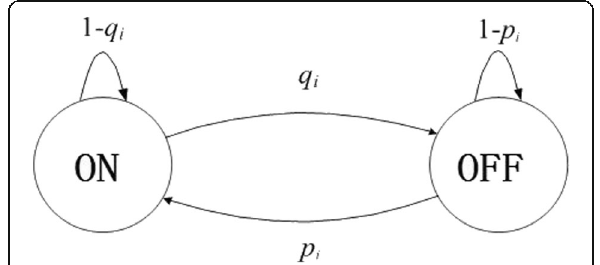
Fig. 2 The semi-Markov ON-OFF model of authorized